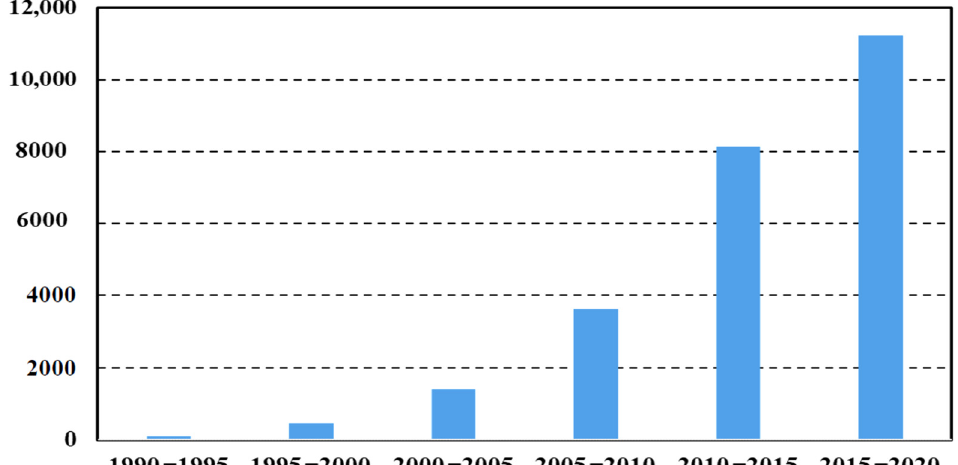
Figure 3. Number of publications on BIPV systems in the past 30 years.